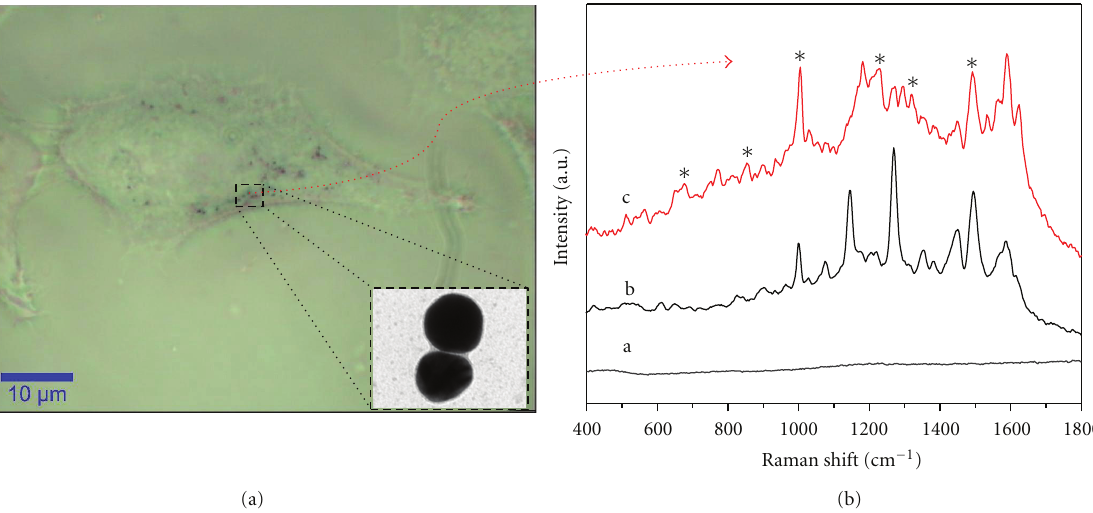
Figure 7: Optical microscopy image of a D407 cell loaded with ascorbate-encoded PEG-GENs (a). SERS spectra of as prepared PEG-GENs in aqueous solution (spectrum b in (b)) and inside the cell (spectrum c in (b)) recorded under 633nm laser line excitation. The asterisks above spectrum c indicate vibrational modes that correspond to cellular components. Spectrum a in (b) represents the Raman spectrum of an individual cell in the absence of nanoparticles, as